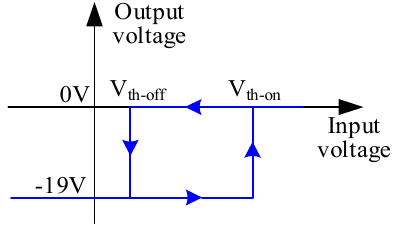
Figure 4. Correlation between the input and output of the driver.